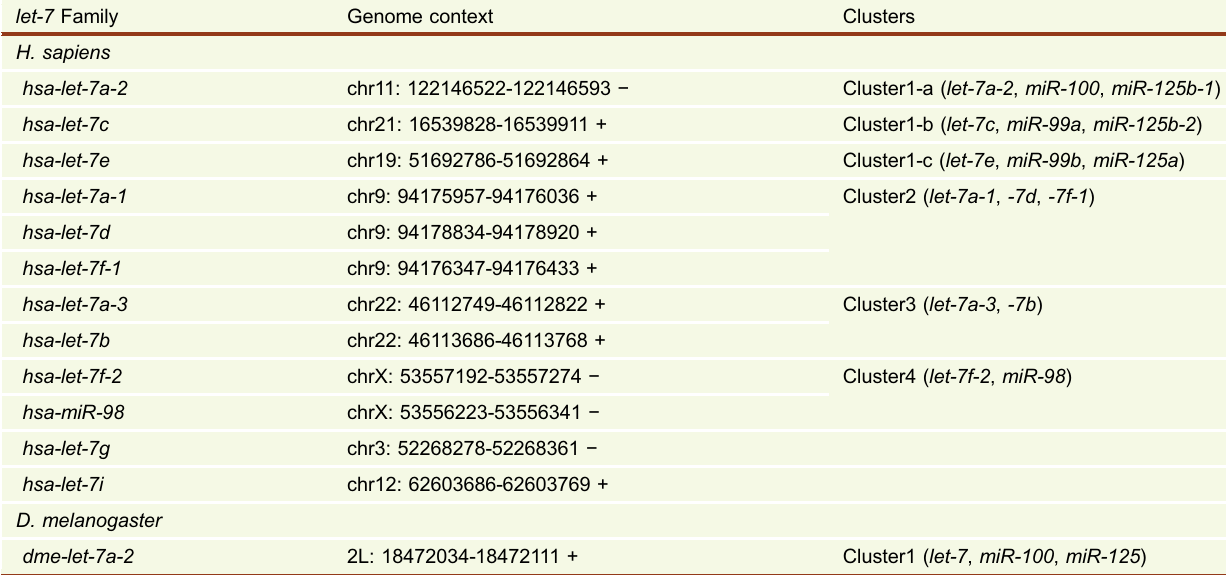
Table 2. Genomic location and conserved clusters of let-7 family in human and fl y let-7 Family Genome context Clusters